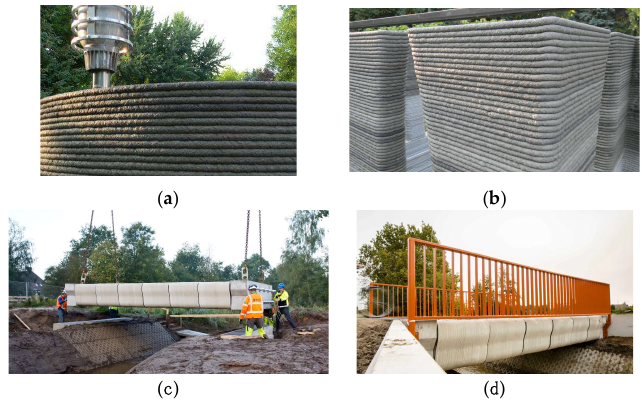
Figure 1. 3D printing technique using concrete material: ( a ) Rudenko (2014), (b) Rudenko (2014); ( c ) Salet, TU/e (2017); ( d ) Salet, TU/e